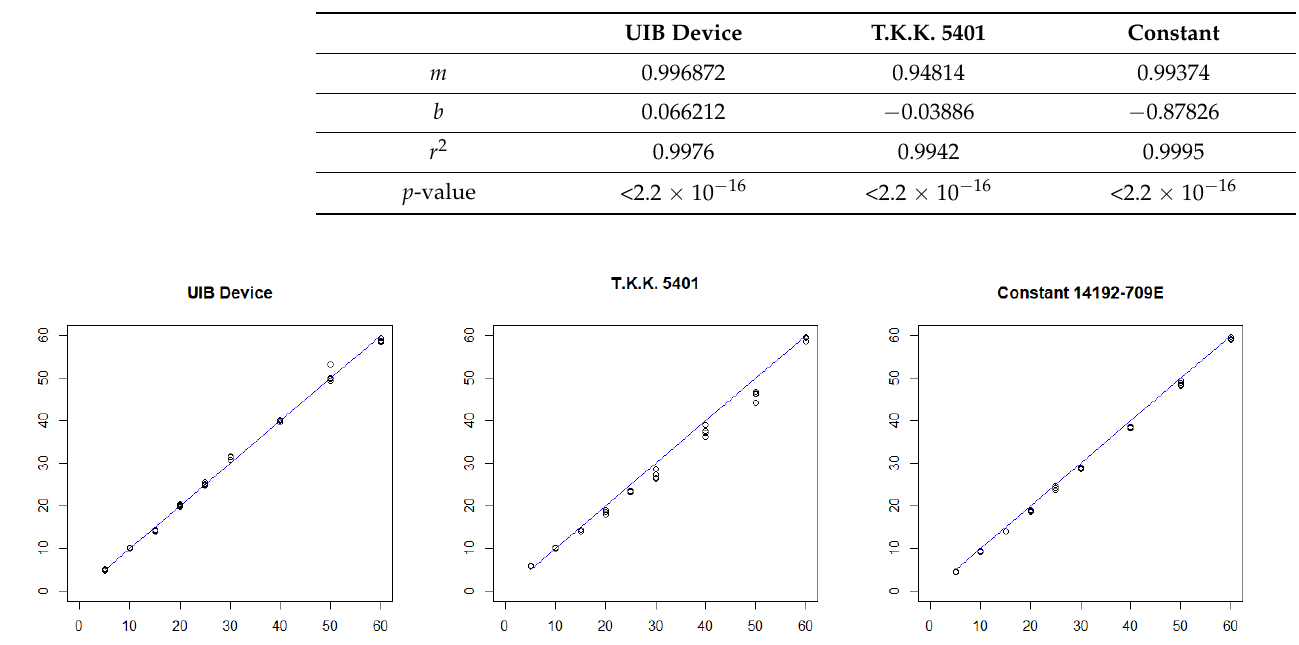
Figure 14. Measurements and linear regression.